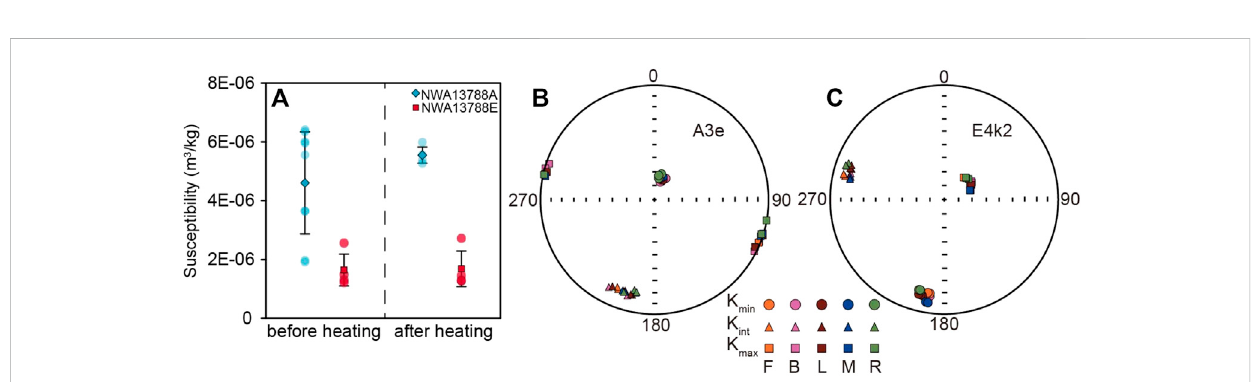
FIGURE 10 (A) Magnetic susceptibilities of specimens from NWA13788A and NWA13788E before and after heating. Mean value and its standard deviation of each sample are shown on the plot. (B) and (C) Equal-area projections of the three principal axes of AMS results of representative specimens from NWA13788. Specimens were measured three times at each